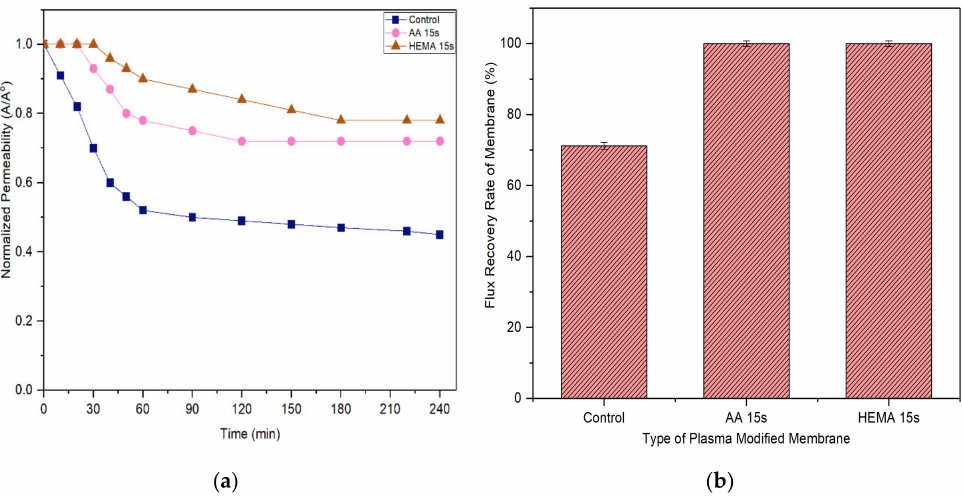
Figure 12. ( a ) Flux decline curves of membranes tested with 2000 mg / L pepsin solution and ( b ) flux recovery rate (FRR) of membranes after water cleaning. Error bars indicate standard